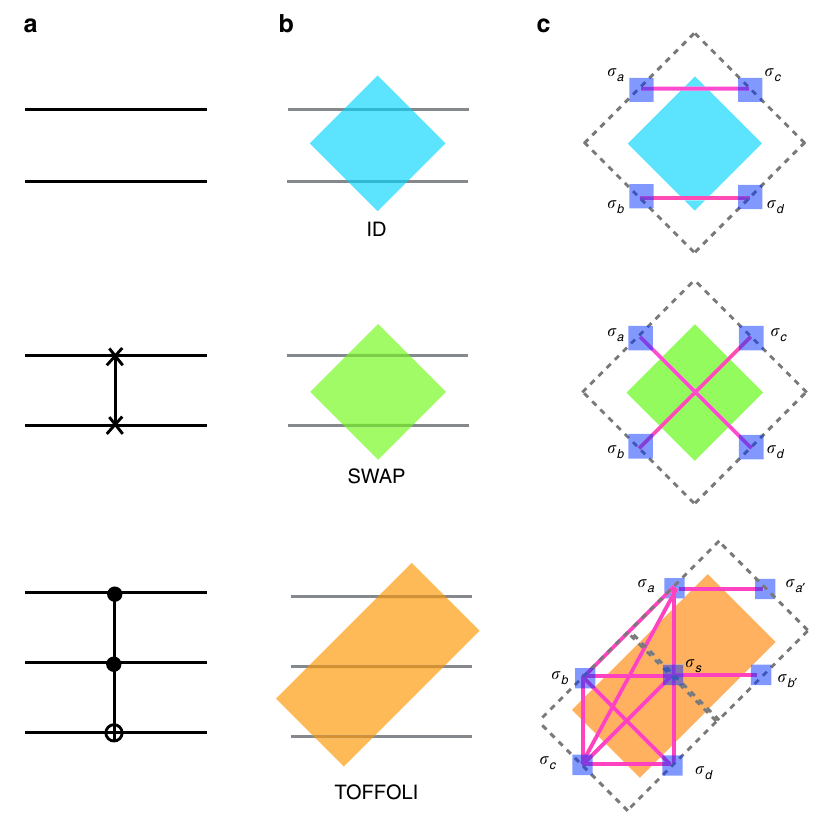
Figure 1 | Tile representation of reversible computational gates. ( a , b ) Elementary tiles representing the three computational gates for reversible circuits: ID (identity), SWAP and TOFFOLI. ( c ) construction of the Hamiltonians that encode the gate-satisfying states in the ground-state manifolds. Spins are placed on the boundary of the tiles. For the TOFFOLI gate, an ancilla spin is placed in the centre of the rectangular tile. Couplings needed in the Hamiltonians for the three different gates (tiles) are indicated by purple lines connecting two spins. The dashed line denotes the boundary of the